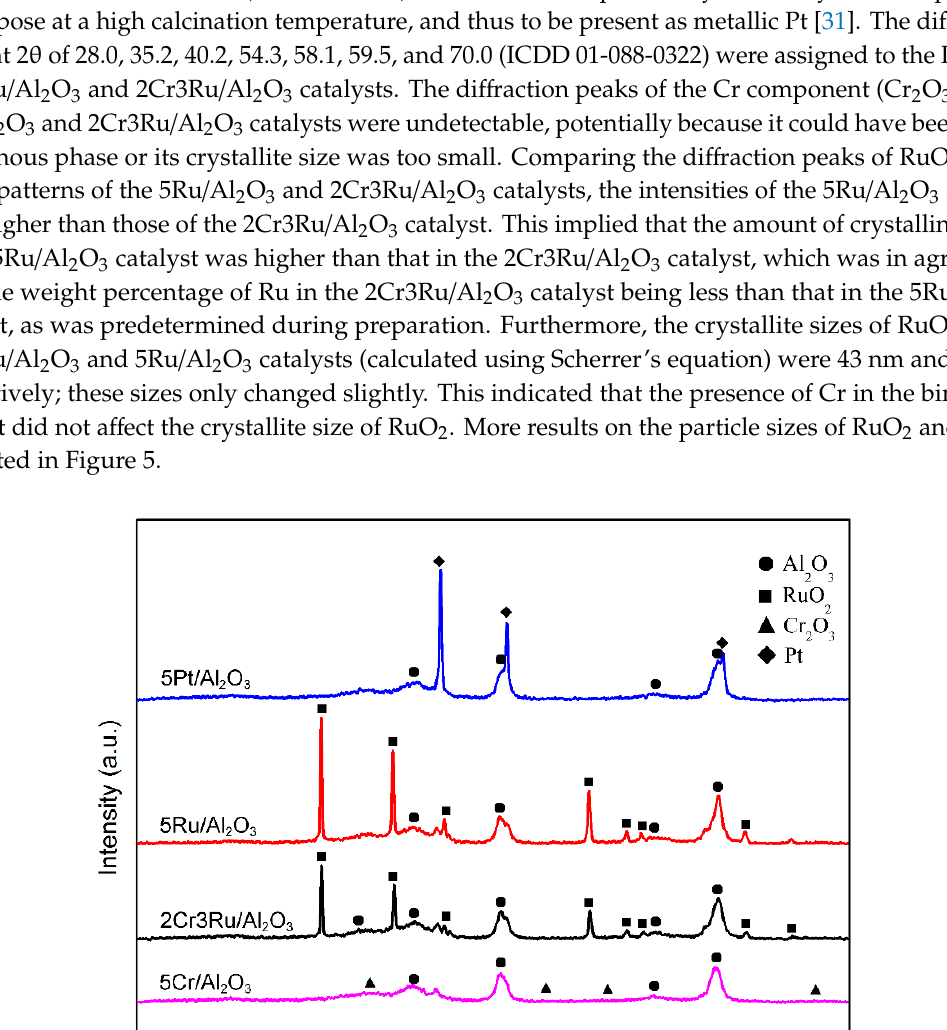
Figure 4. H 2 -TRP profiles of fresh 5Pt, 5Ru, 5Cr, and 2Cr3Ru supported on Al 2 O 3 . Figure 5 shows the SEM images, SEM/EDS images, and EDS spectra of the fresh 5Pt/Al 2 O 3 , 5Ru/Al 2 O 3 , 5Cr/Al 2 O 3 , and 2Cr3Ru/Al 2 O 3 catalysts. The SEM images for all catalysts were similar; the particles were irregular in shape, and the particle sizes were approximately 50–100 nm, mostly representing the γ -Al 2 O 3 support. For all catalysts, the micro-scale distribution of each metal was uniform throughout the catalytic materials (see SEM-EDS image in Figure 5). The EDS spectra of each catalyst confirmed that each element impregnated onto the γ -Al 2 O 3 support was present in the materials.